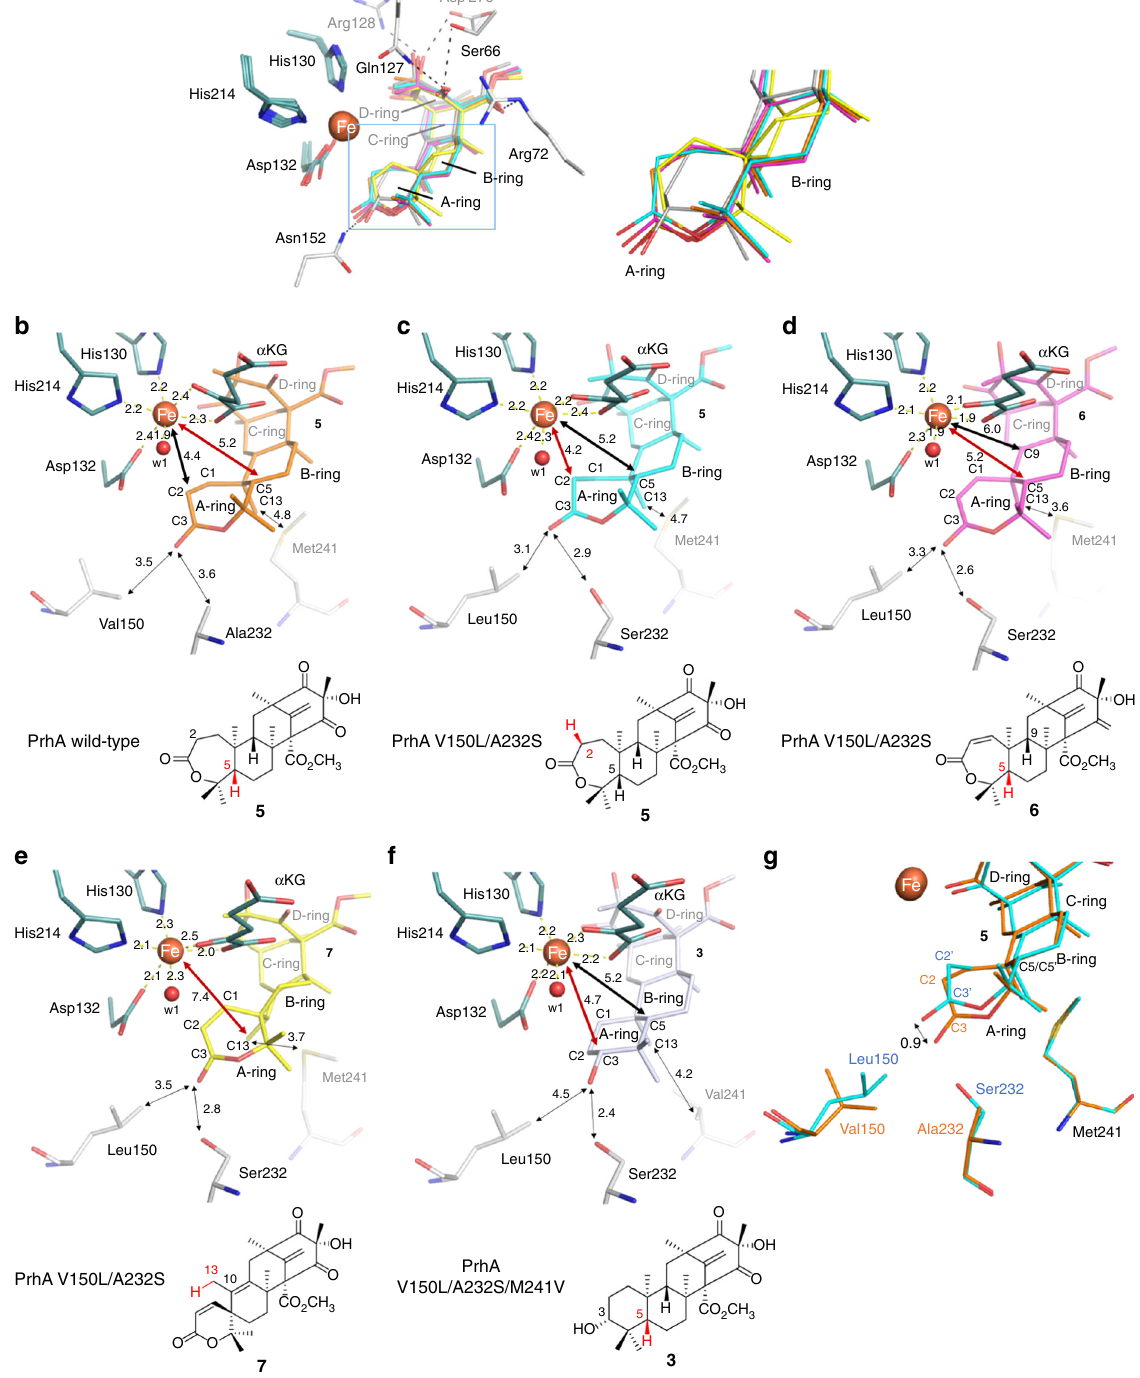
Fig. 5 Comparison of the active site structures of the wild-type and the mutant PrhA. a Superimposition of the active site of PrhA-Fe/ α KG/ 5 , PrhA(V150L/ A232S)-Fe/ α KG/ 5 , PrhA(V150L/A232S)-Fe/ α KG/ 6 , PrhA(V150L/A232S)-Fe/ α KG/ 7 , and PrhA(V150L/A232S/M241V)-Fe/ α KG/ 3 . Substrates in each structure are colored in orange, cyan, magenta, yellow, and white, respectively. Close-up view of the boxed A/B-ring region is shown on the right. Amino acid residues interacting with 5 in PrhA-Fe/ α KG/ 5 structure are shown as stick model (white). b – f Close-up views of the active site of PrhA-Fe/ α KG/ 5 ( b ), PrhA(V150L/A232S)-Fe/ α KG/ 5 ( c ), PrhA(V150L/A232S)-Fe/ α KG/ 6 ( d ), PrhA(V150L/A232S)-Fe/ α KG/ 7 ( e ), and PrhA(V150L/A232S/M241V)-Fe/ α KG/ 3 ( f ). g Superimposition of the active site of PrhA-Fe/ α KG/ 5 and PrhA(V150L/A232S)-Fe/ α KG/